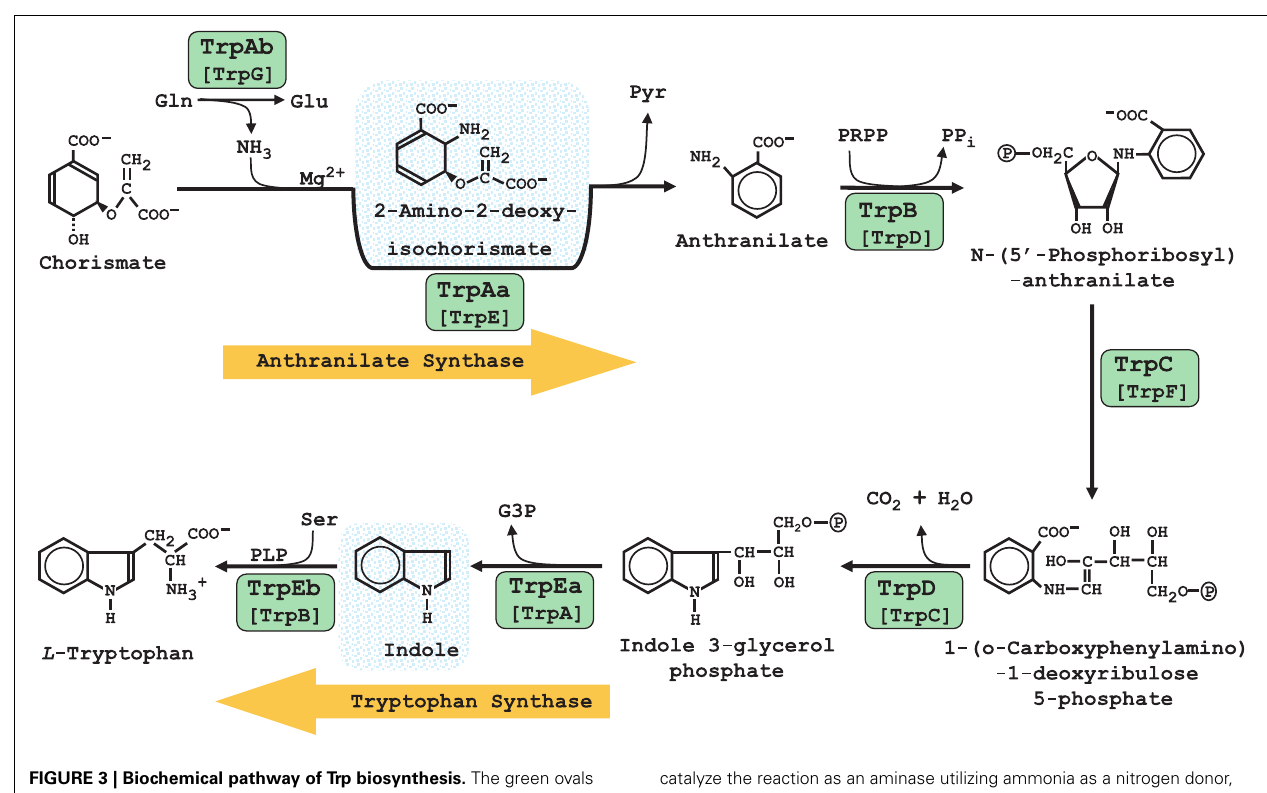
catalyze the reaction as an aminase utilizing ammonia as a nitrogen donor, but the physiological reaction is carried out as an amidotransferase via the contribution of the TrpAb subunit which utilizes glutamine as the source of the ammonia reactant. Although tryptophan synthase is a two-subunit complex in which indole is an enzyme-bound intermediate, isolated TrpEb is capable of utilizing free